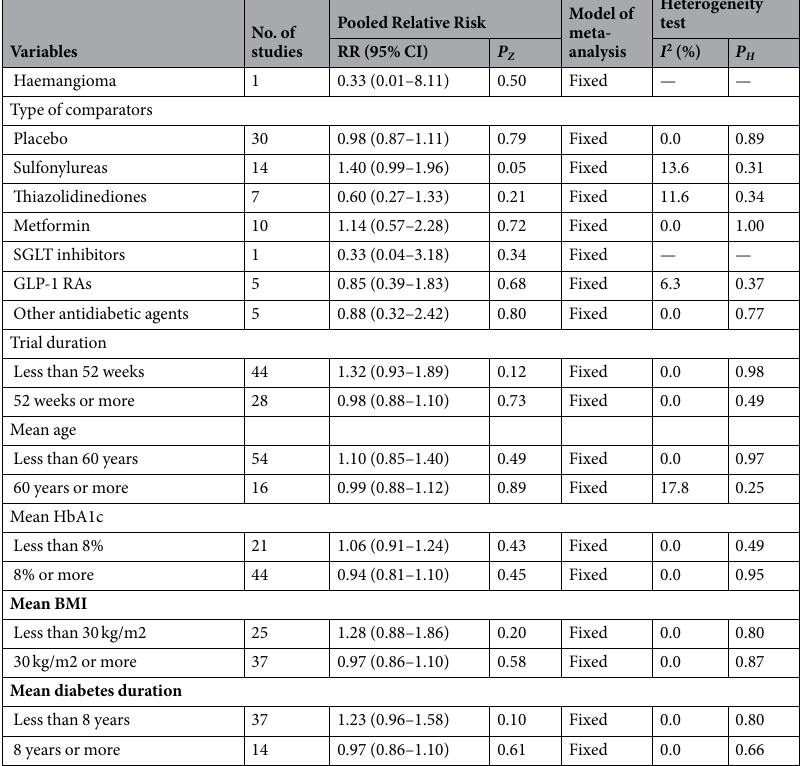
p = 0.053), thiazolidinediones (MH-RR = 0.60, 95% CI = 0.27–1.33, p = 0.209). A new-user cohort study con- ducted by Gokhale et al . 43 reported that the hazard of pancreatic cancer with DPP4i was similar to that with thiazolidinediones (HR = 1.0, 95% CI = 0.7–1.4) but lower than that with sulfonyureas (hazard ratio (HR) =